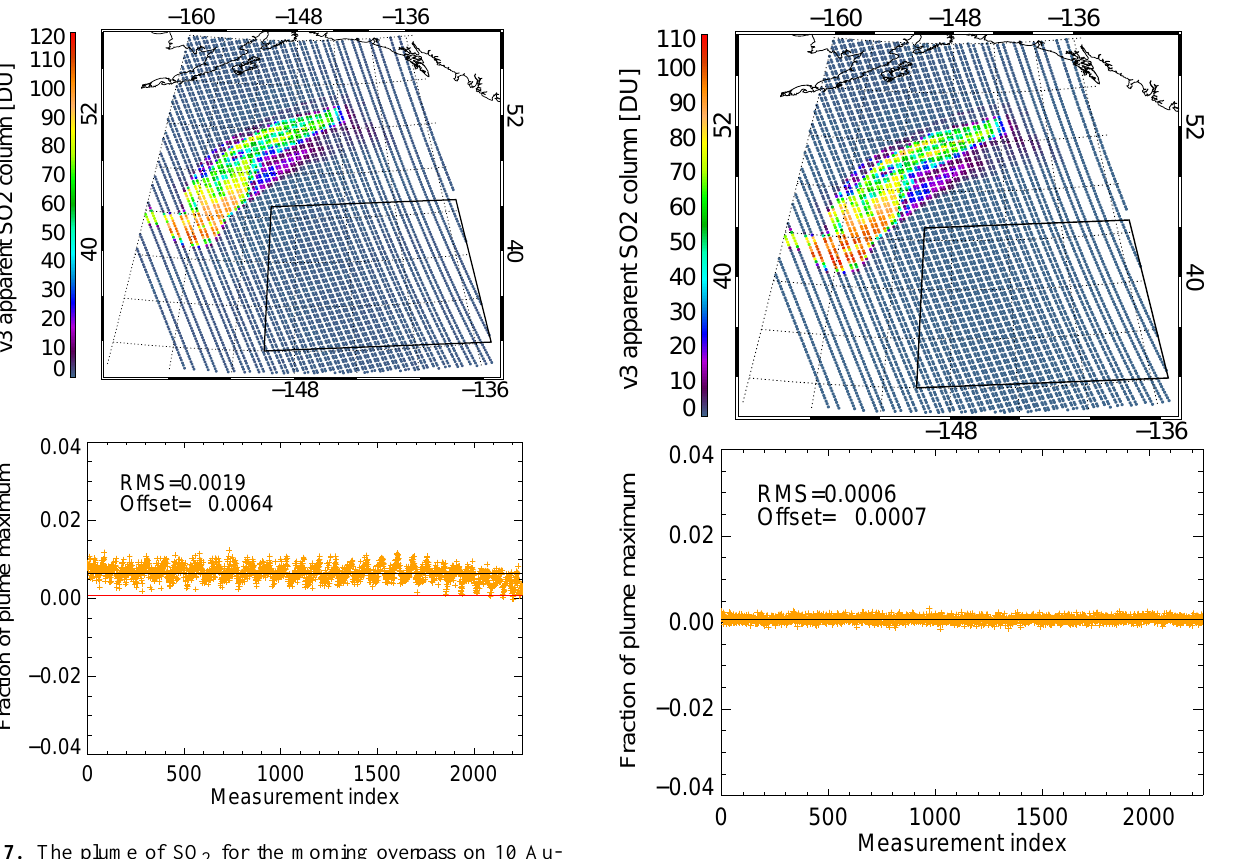
Fig. 8. The plume of SO 2 for the morning overpass on 10 Au- gust 2008 using the ν 3 band filter for Method (3) as described in the text using the ensemble approach to compute S tot (cid:15) . Fractional varia- tion in the background normalised according to the maximum value within the plume (107DU) shown in the bottom panel for IFOV’s inside box. Reported 1 σ sensitivity ( σ c ) for this filter of 0.0006 (=0.067DU). Observed RMS of background=0.0006. Expected climatological value shown as red line. Mean value of background value shown as black